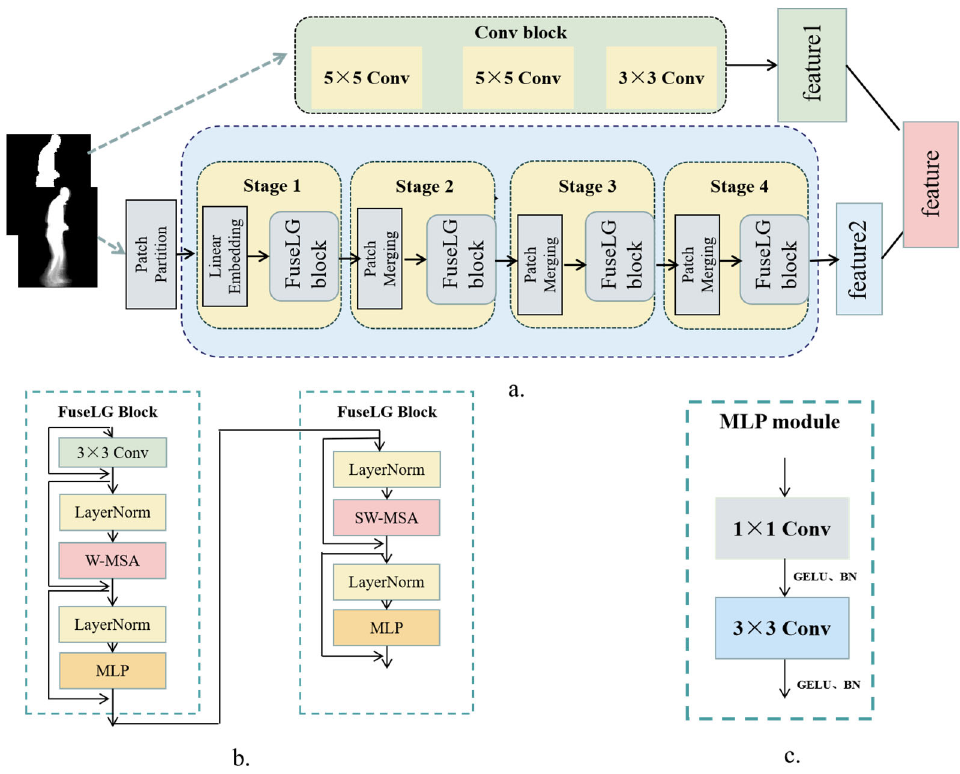
Figure 1. The structure of the proposed FuseLGNet. ( a ) corresponds to the model overview; ( b ) represents the FuseLG block; ( c ) depicts the MLP module. Note that W-MSA and SW-MSA are used in pairs.